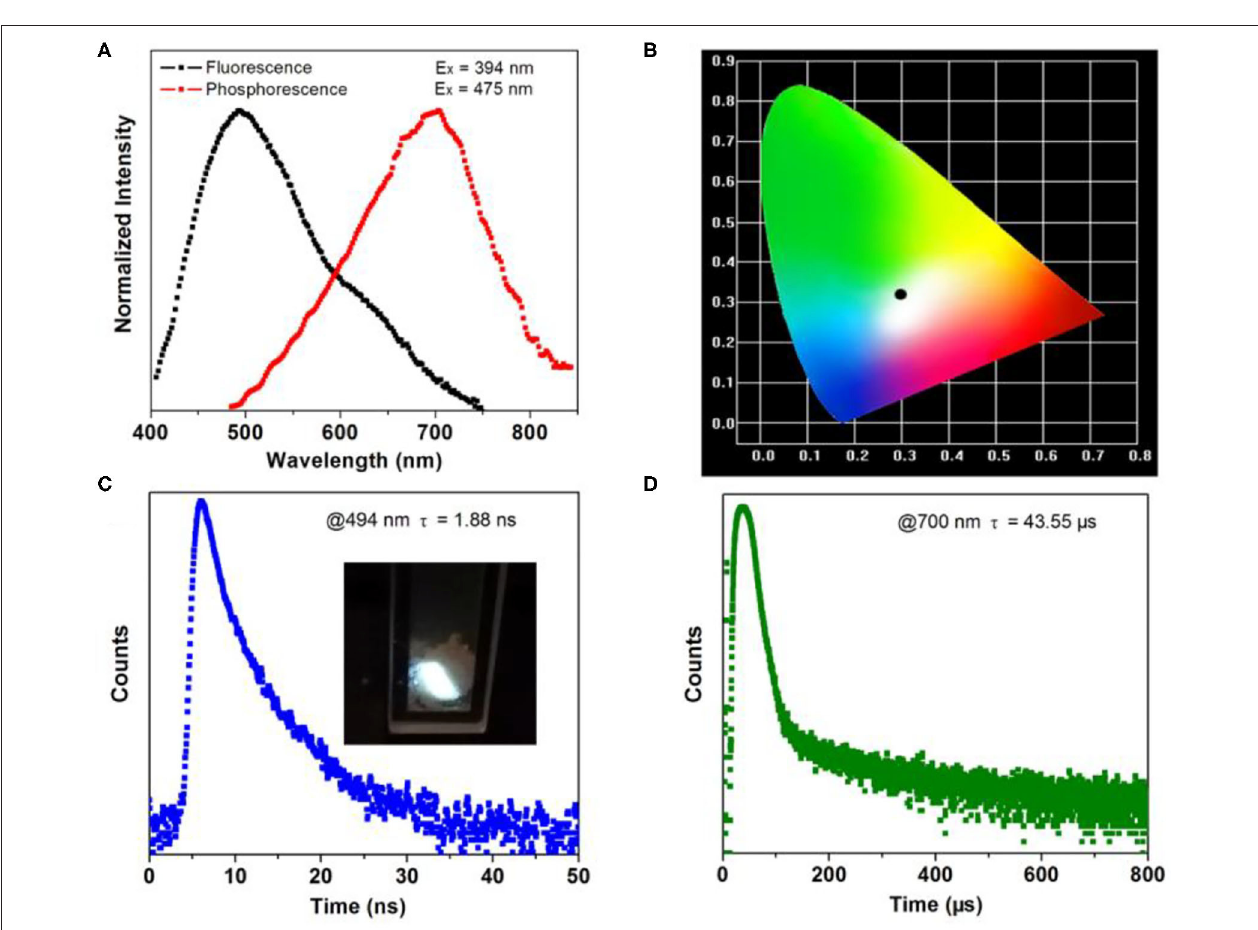
FIGURE 3 | (A) Normalized fluorescence/phosphorescence spectra of 1 . (B) CIE-1931 chromaticity diagram of 1 . Fluorescence (C) and phosphorescence (D) decay curves of 1 measured at room temperature. Insets show the crystal sample of 1 under UV (365nm) light.